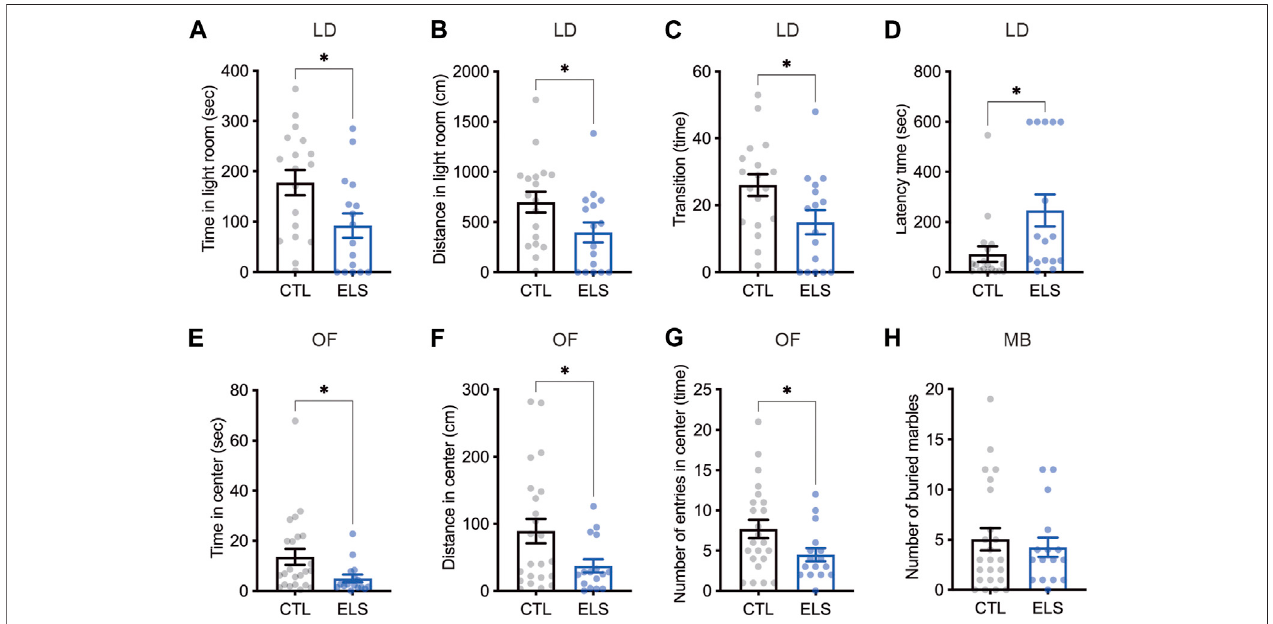
FIGURE 3 | Increased anxiety-like behaviors in ELS mice. (A – D) Quanti fi cations of light-dark box test result. Signi fi cant reductions of time (A) and distance (B) in light room, the transition number between the rooms (C) , and latency time to enter the light room (D) were observed in adolescent ELS mice. LD, light-dark box test. (E – G) Quanti fi cations of open fi eld test result. Signi fi cant reductions of time (E) , distance (F) , and the number of entries (G) in center were observed in adolescent ELS mice. (H) Quanti fi cation of the number of buried marbles. There was no difference in the repetitive behavior in adolescent ELS mice. MB, marble-burying test; OF, open fi eld test. Data are presented as means ( ± SEM). Asterisk indicates *p < 0.05, unpaired t -test, n (cid:2) 16 – 18/condition for LD, n (cid:2) 16 – 23/condition for OF, n (cid:2) 16 – 23/ condition for